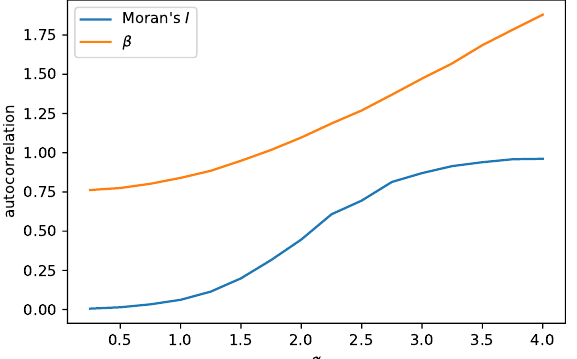
Figure 2. Measures of autocorrelation as a function of α